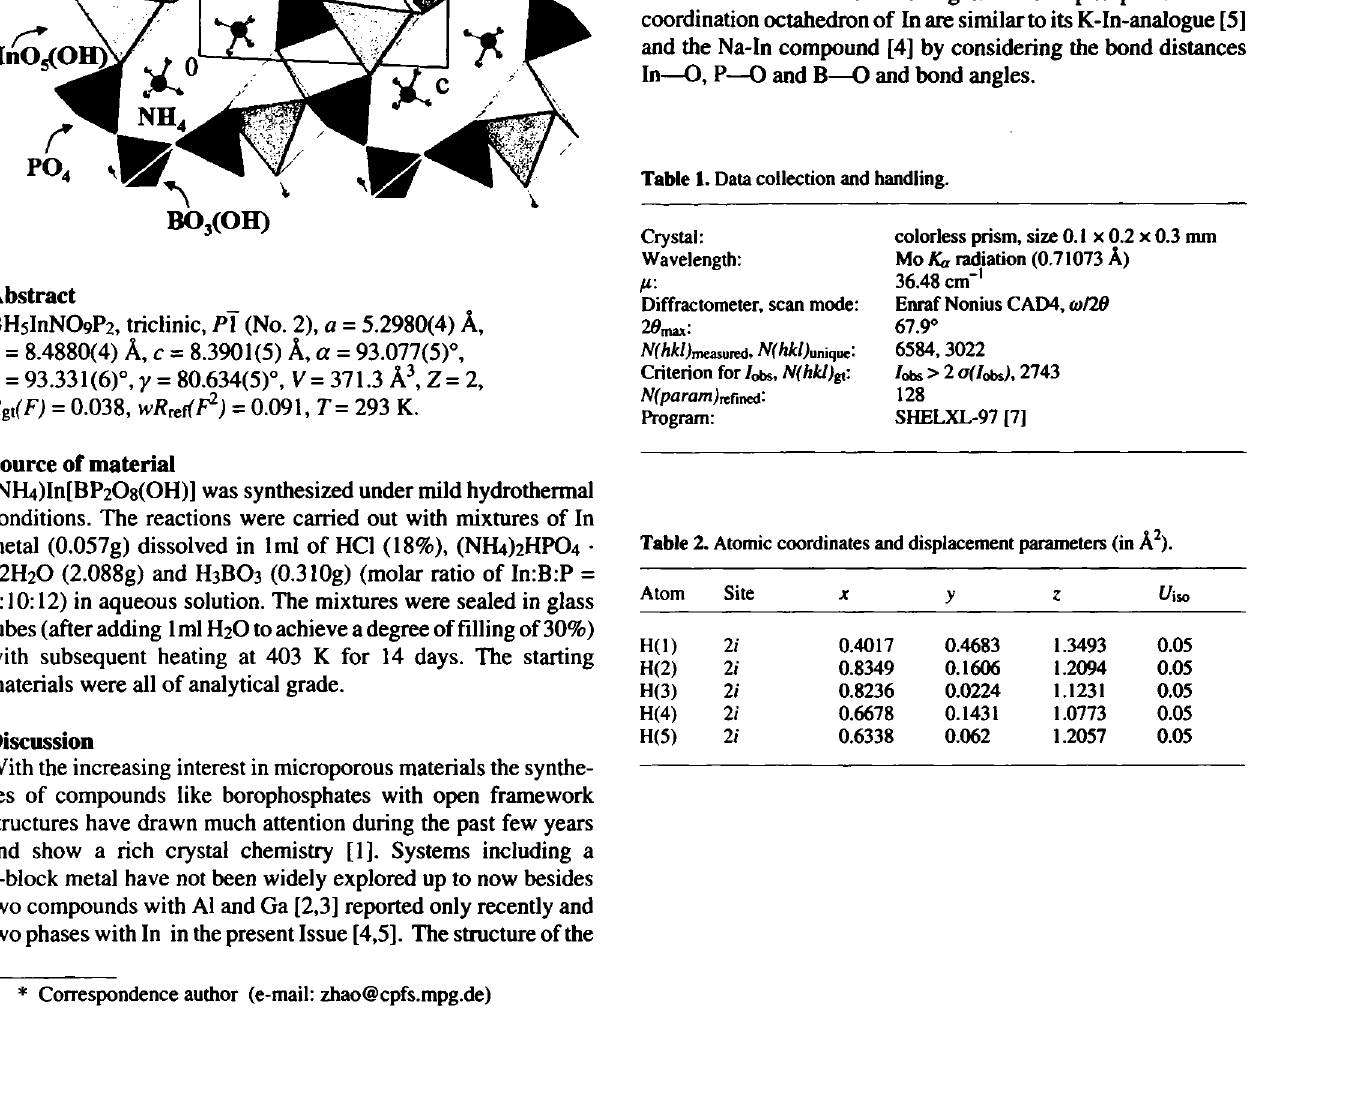
Table 1. Data collection and handling.